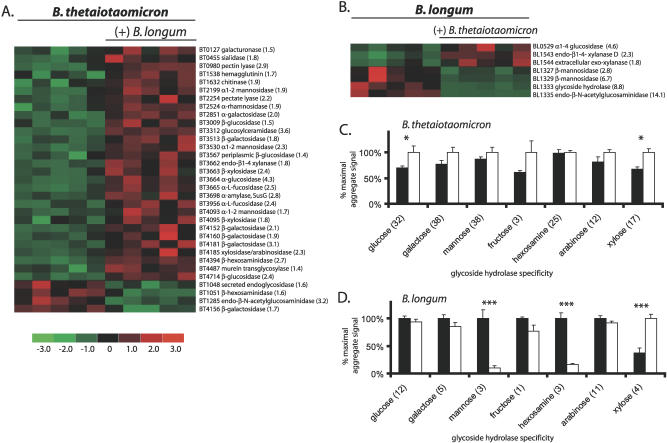
Impact of Co-colonization on B. thetaiotaomicron and B. longum Glycoside Hydrolase and Polysaccharide Lyase Gene Expression(A) and (B) Bacterial glycoside hydrolase and polysaccharide lyase genes (rows) exhibiting differential expression in mono-associated versus co-colonized mice. Colors indicate the deviation of a gene's signal above (red) and below (green) its mean expression value across all ten samples. Thirty-three B. thetaiotaomicron enzymes and seven B. longum enzymes meet the selection criteria for differential expression described in Materials and Methods (FDR < 0.01). Fold-differences in average expression levels between the two colonization states are indicated in parenthesis for each gene.(C) and (D) Average aggregate signal intensity in the two colonization states for the seven groups of glycoside hydrolases/polysaccharide lyases that are common to B. thetaiotaomicron (C) and B. longum (D). The number of enzymes in each group is indicated in parenthesis. Values obtained from mono-associated mice are shown with black bars, and from co-colonized mice with white bars. See Tables S14 and S15 for a list of the B. thetaiotaomicron and B. longum genes, respectively. See Materials and Methods for a description of how “% maximum aggregate signal” was calculated. Mean values ± standard error (S.E.) of five samples are shown: an asterisk (*) indicates p < 0.05, and double asterisks (**) indicate p < 0.001 according to Student t-test.